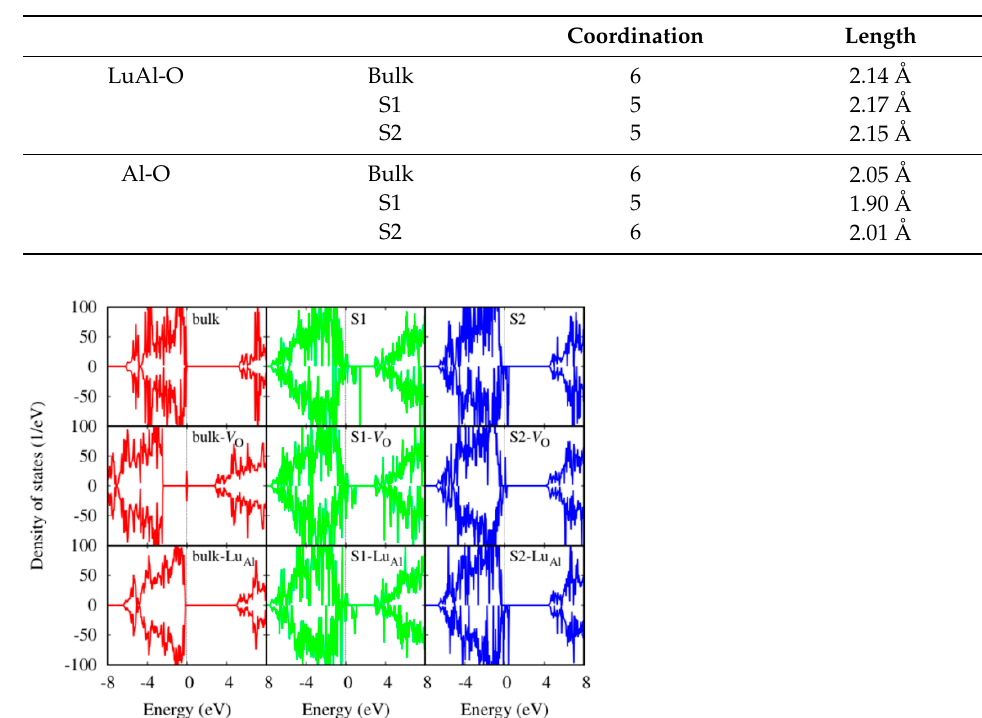
Table 3. The calculated structure data of antisite defects Lu Al and Al atoms.